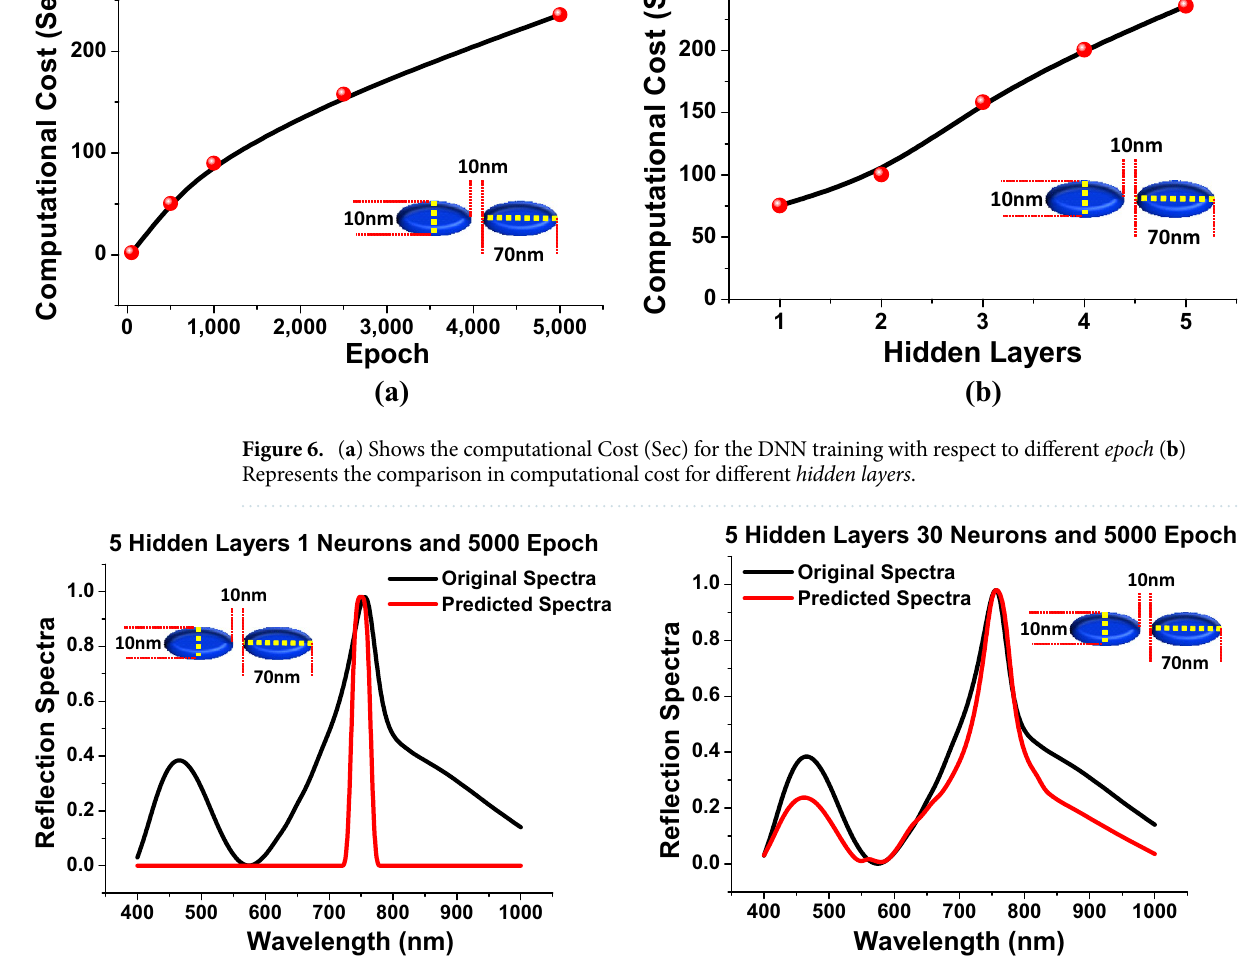
Figure 7. Hidden layers = 5 and Epoch = 5000 ( a ) Shows the comparison of predicted reflection spectra with respect to the original reflection spectra at neuron = 1 ( b ) Represents the resemblance of predicted reflection spectra with respect to the original reflection spectra at neuron =